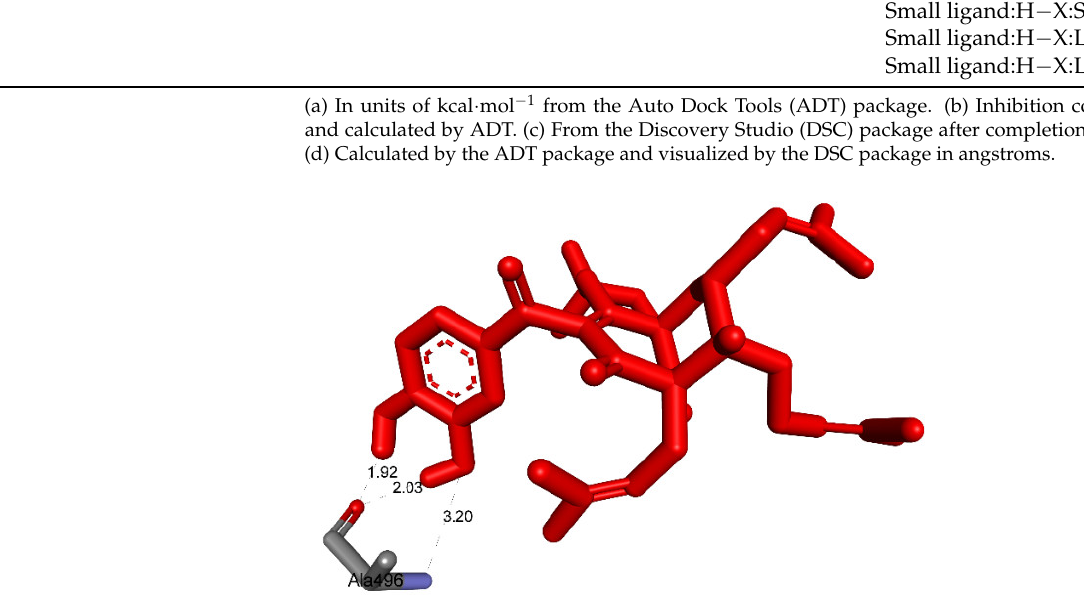
Figure 16. The hydrogen bonds and electrostatic interactions linked from active atoms on pose 158, compound 1 , to active residual amino acids on enzyme 2VF5.